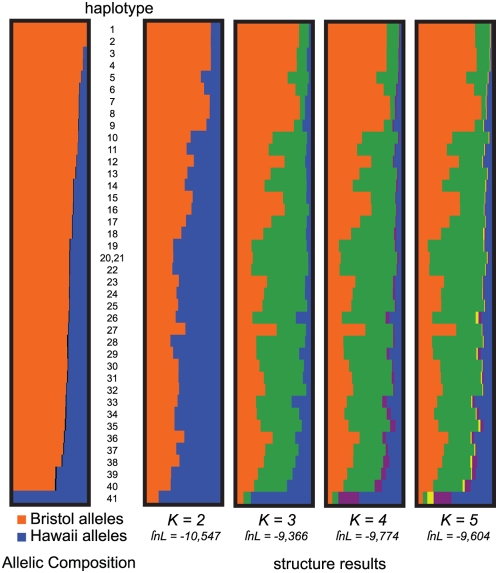
Population Structure.Distinguishable wild isolate haplotypes are represented as rows. At left, the allelic composition of each haplotype is represented by orange and blue bars. At right, population assignments from structure are shown for each haplotype, with the most N2-like ancestral population orange and the most CB4856-like blue. Likelihoods for alternative numbers of ancestral populations (K) are shown below each plot. At K = 1, lnL = −23076.